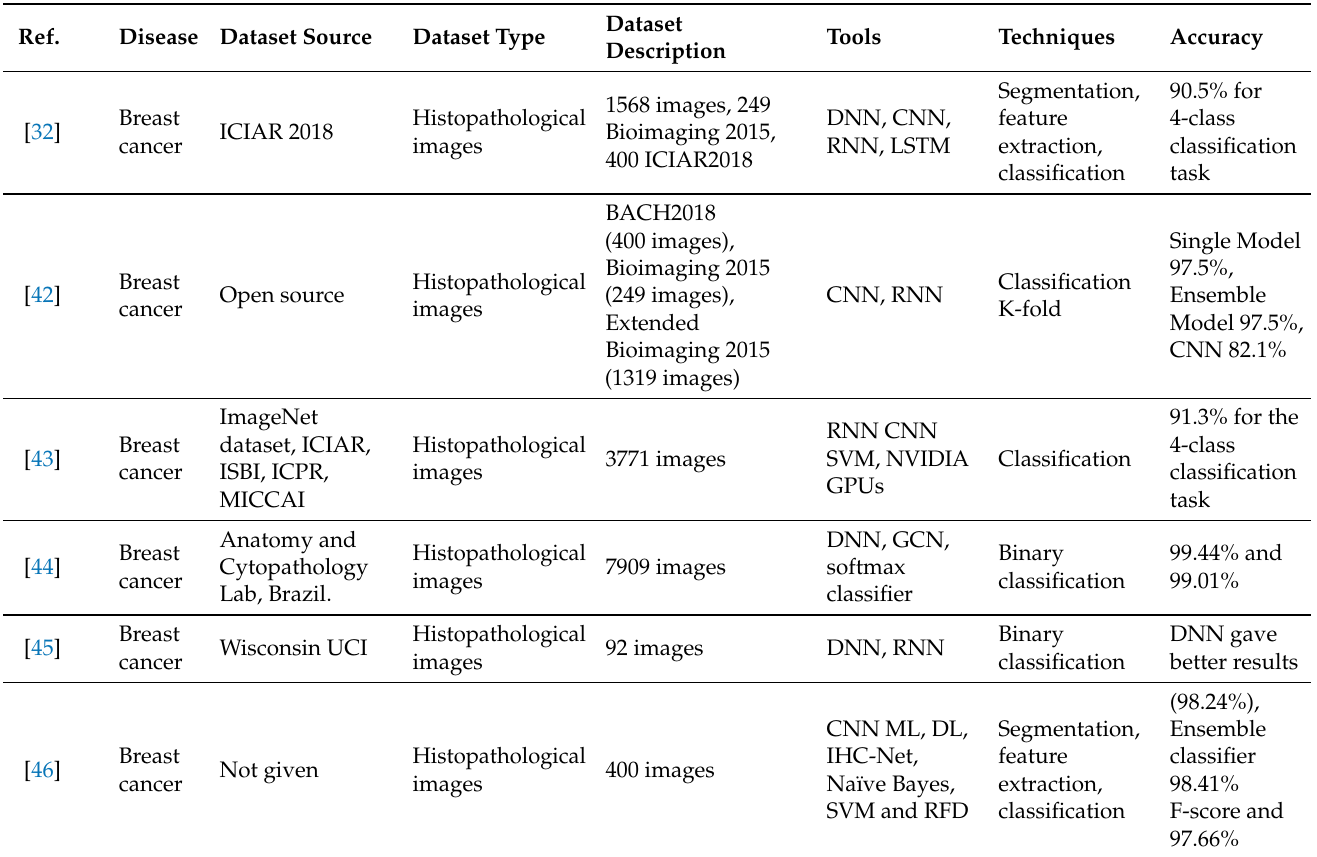
Table 2. Existing techniques on histopathological images dataset.